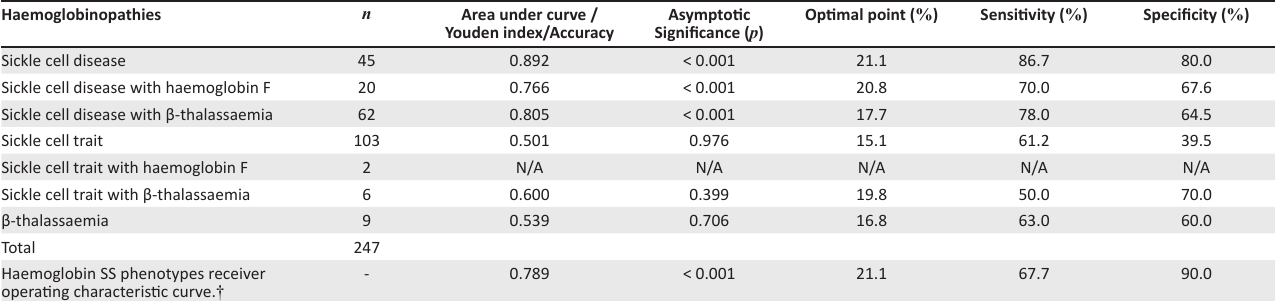
TABLE 2: Summary of RDW predictive ability in haemoglobin disorders in western Kenya, 01 January 2015 – 31 December 2020. Haemoglobinopathies n